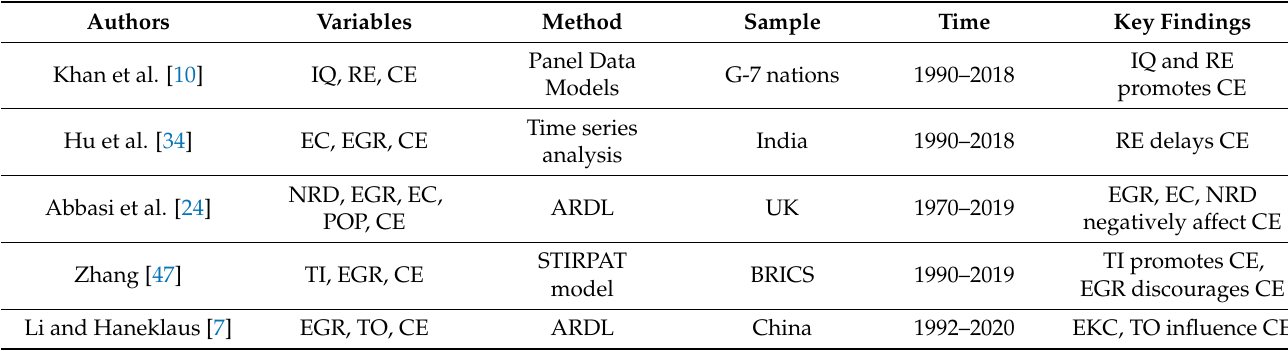
Table 2. Summary of Carbon Neutrality